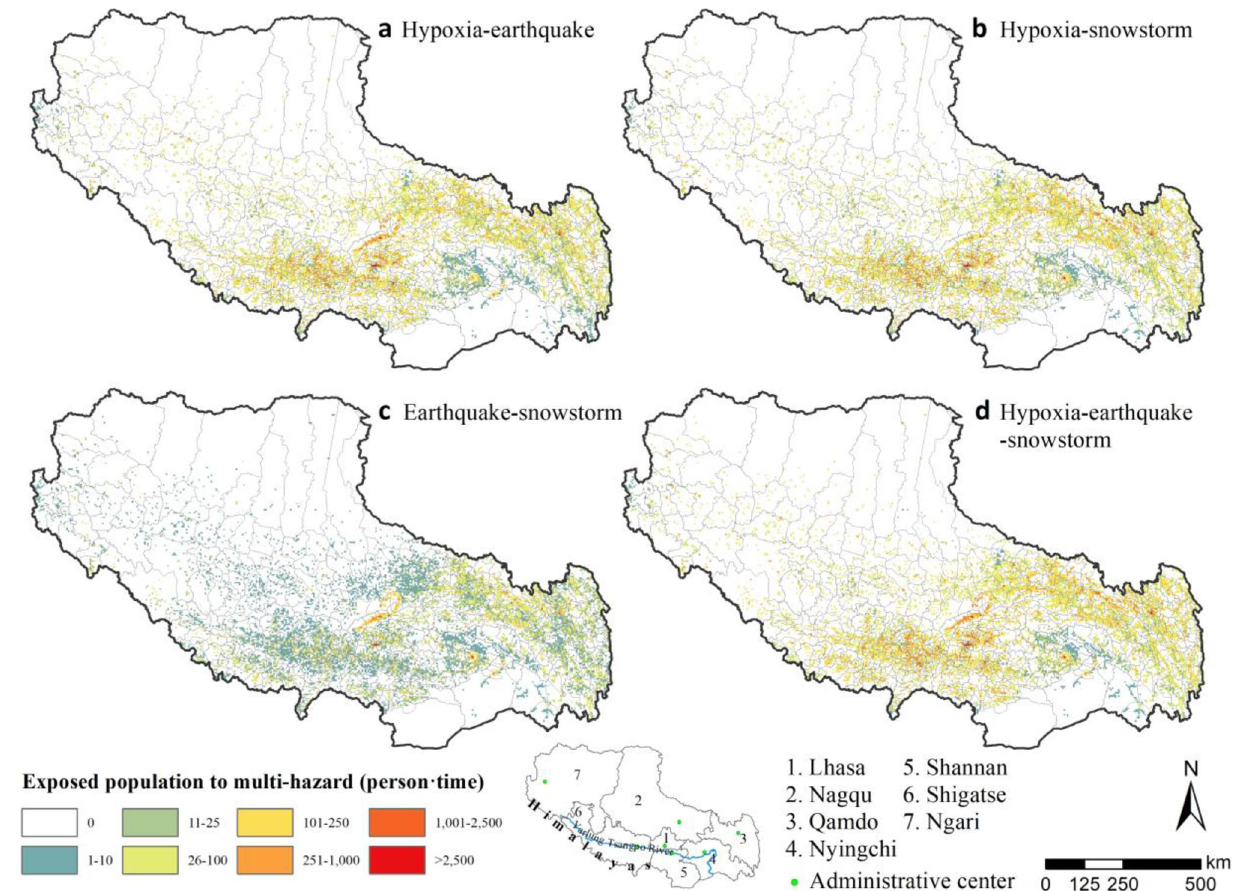
Fig. 4 Spatial distributions in Tibet of person (cid:2) time exposure to multi-hazards: a hypoxia-earthquake, b hypoxia-snowstorm, c earthquake- snowstorm, d hypoxia-earthquake-snowstorm,